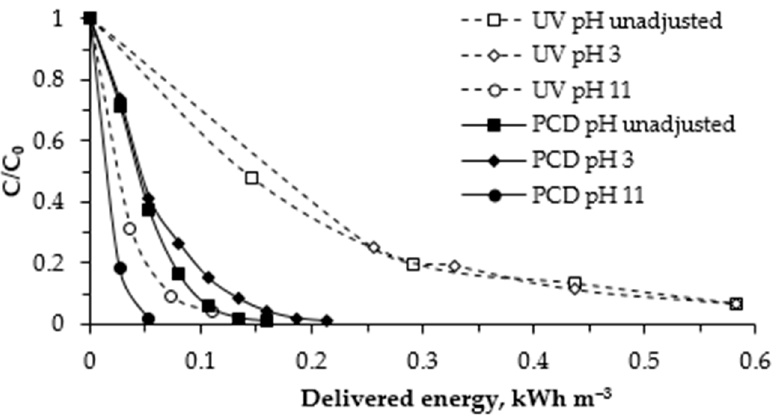
Figure 1. Degradation of VMN at different pH values in UV photolysis and PCD treatment ([VMN] 0 = 13.5 µM). ([VMN] µ 0 = 13.5